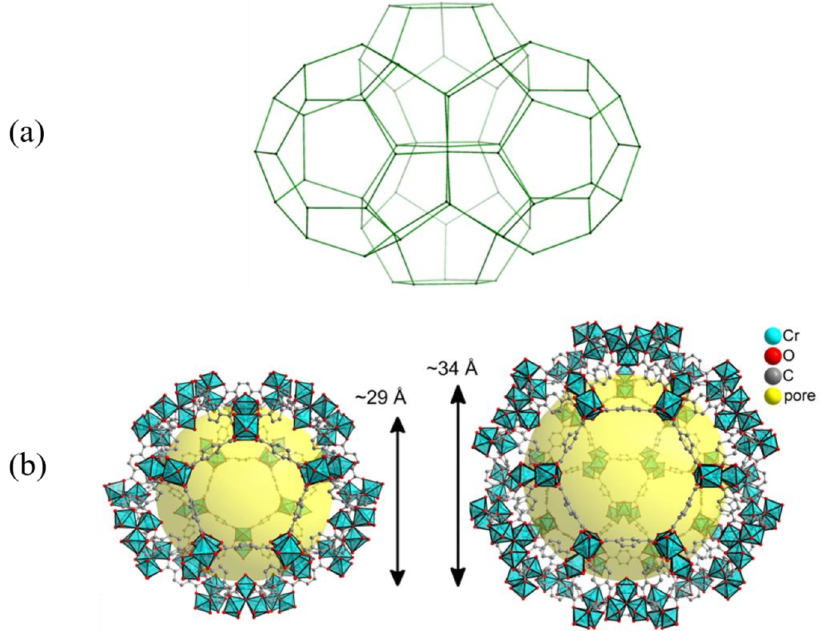
Figure 2. ( a ) Framework structure of MIL-101. ( b ) small cage with pentagonal windows and large cage with pentagonal and hexagonal windows with pore diameters (yellow spheres). The yellow spheres in the mesoporous cages with diameter of 29 or 34 Å, respectively, take into account the van-der-Waals radii of the framework walls (water-guest molecules are not shown).